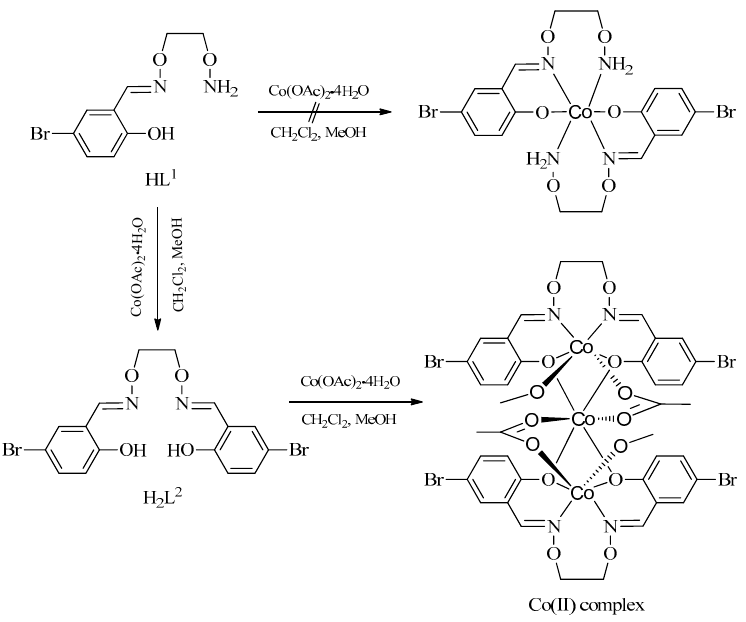
Scheme 1. Synthesis of the Co(II) complex. Table 1. Crystal data for the Co(II)